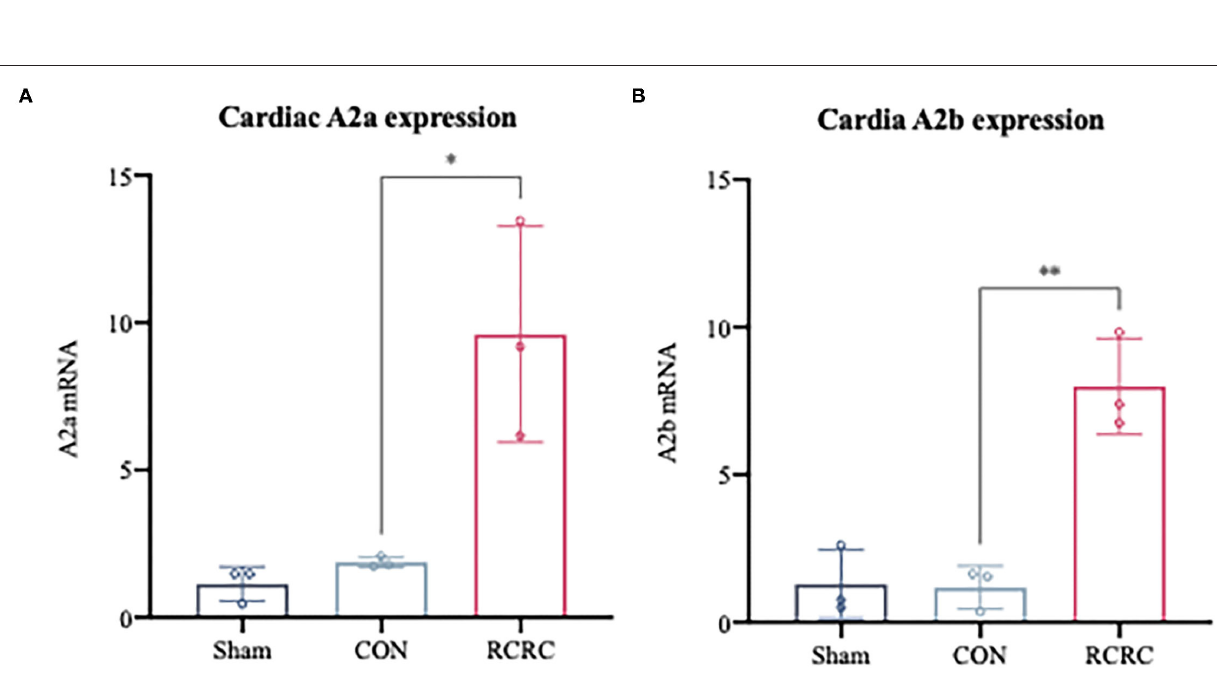
Frontiers in Cardiovascular Medicine |